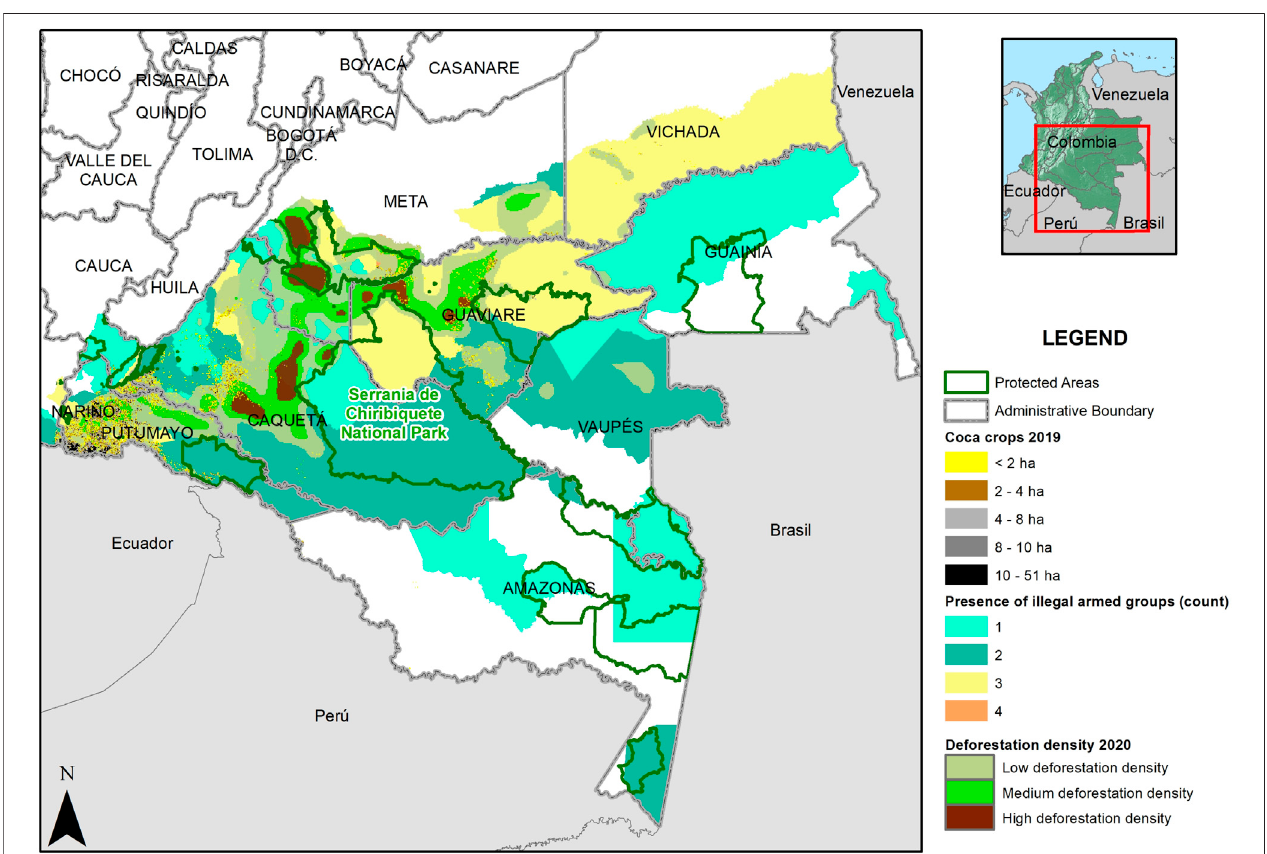
FIGURE 2 | Map of Colombia focusing on the Amazon Region, produced by Alejandra Gomez, commissioned by the authors.